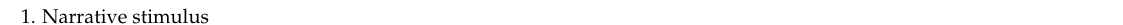
Table 1. Interview questionnaire. The interview followed a narrative approach, whereby patients first talked about their disease journey to diagnosis and about their glaucoma in general. This was followed by key questions about adherence and eye drop management, the doctor-patient relationship, and other topics. Additionally, patients had the opportunity to talk about their recommendations for other patients.